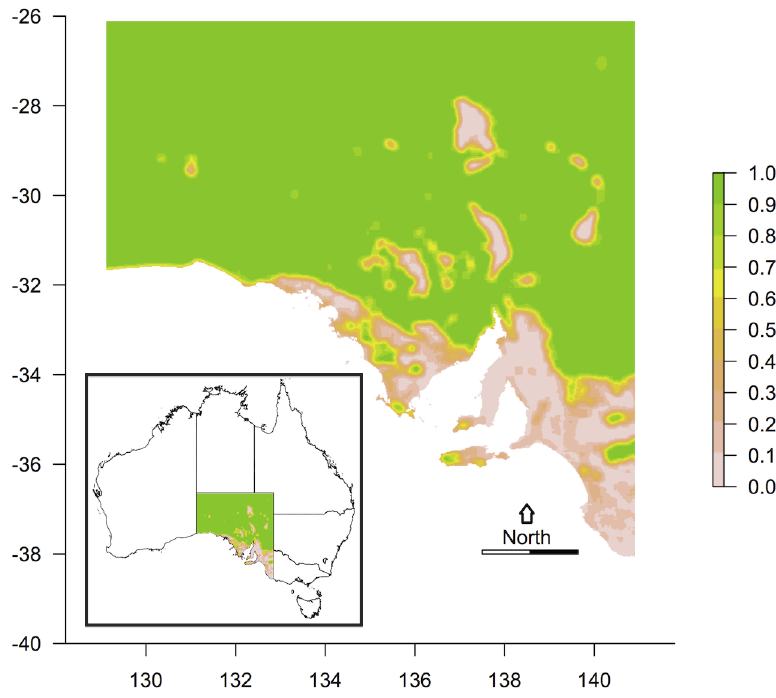
Fig 1. Study region. South Australia on the mainland of the Australian continent (plus its off-shore islands), showing the proportion of remnant native vegetation within a moving window of 25 x 25 km (large areas with no vegetation in the north are salt lakes). Scale bar: 200 km. Inset: context within